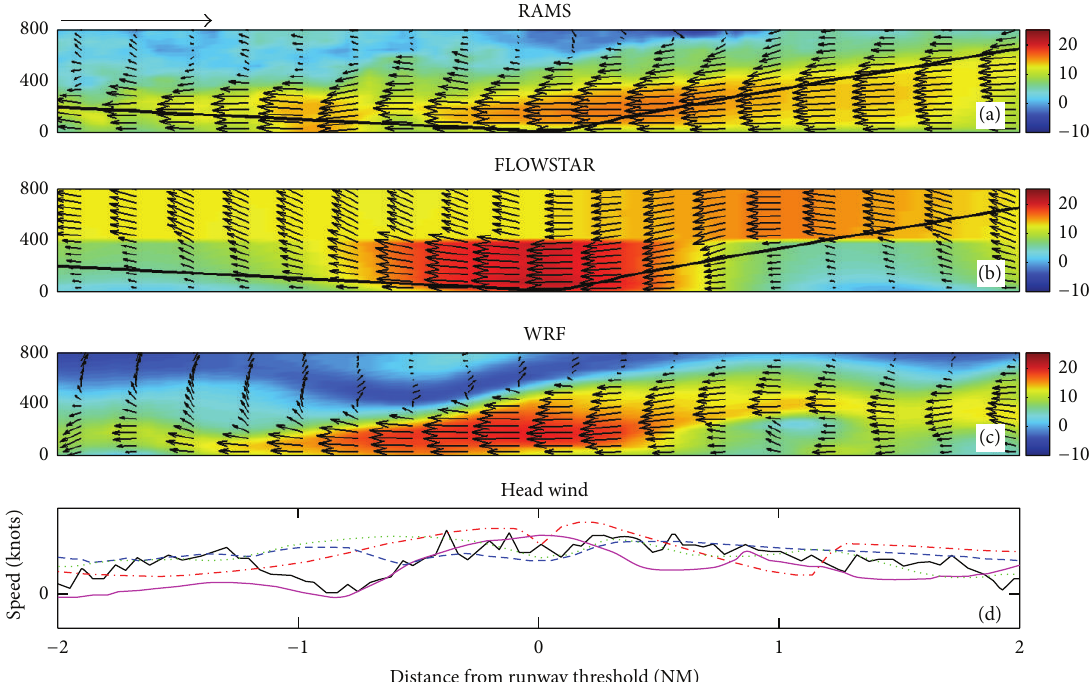
Figure 1: (a)–(c) Horizontal wind speeds (in knots) for RAMS, FLOWSTAR, and WRF, respectively, along the landing corridor. The thick black solid curve in each figure is the landing trajectory. The vector field is the plot of headwind and vertical velocity along the landing corridor, where hints of coherent structures can be seen. (d) Headwind comparison between measurements and models. Thick black solid curve: onboard measurement. Magenta curve: LIDAR measurements along the PPI scanning cone. Blue dashed curve: interpolated headwind from RAMS. Red dash-dotted curve: interpolated headwind from FLOWSTAR. Green dotted curve: interpolated headwind from WRF. The black arrow above (a) indicates direction of